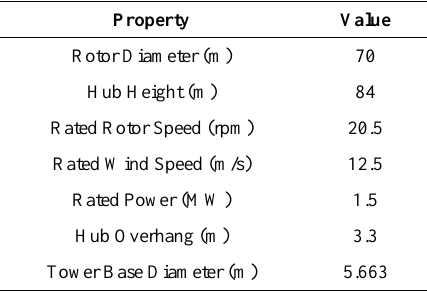
Table 1. Properties of WindPact 1.5 MW